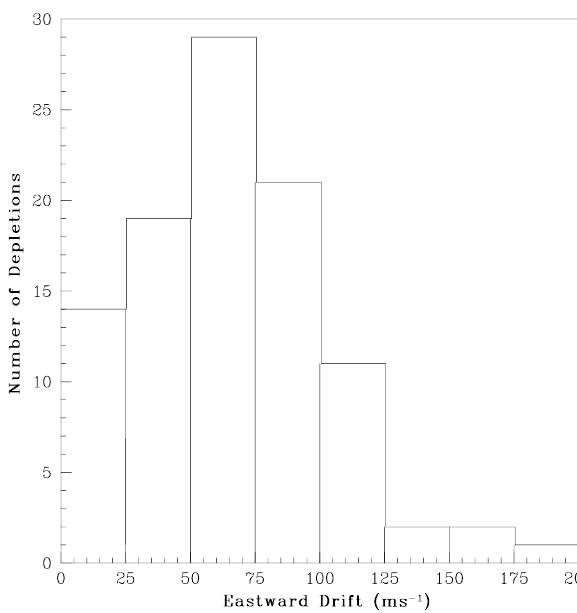
Fig. 10. Histogram of the number of depletions observed in differ- ent velocity ranges during all eight nights of